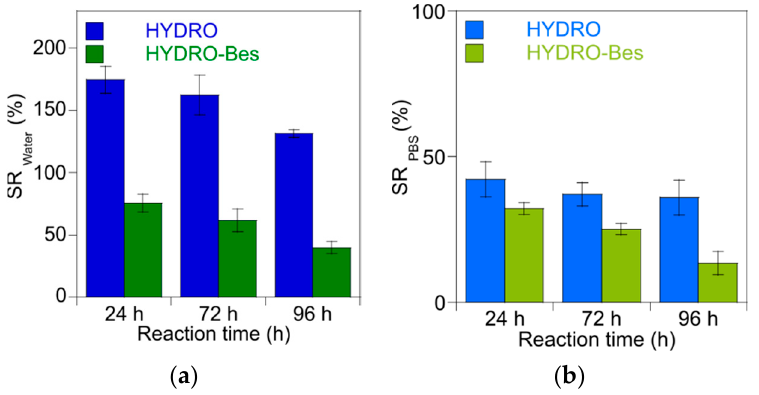
Figure 4. Swelling ratio (SR) of hydrogels measured at 37 °C after 24, 72, or 96 h of crosslinking: ( a ) SR in distilled water ( b ) in PBS.